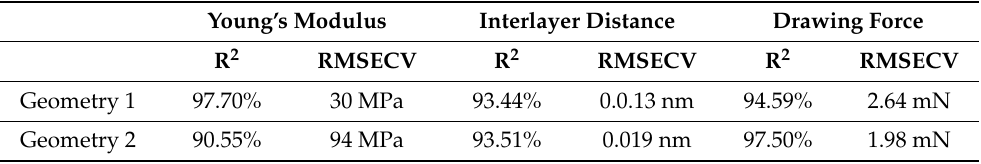
Table 1. RMSECV for Young’s modulus, interlayer distance and drawing force using